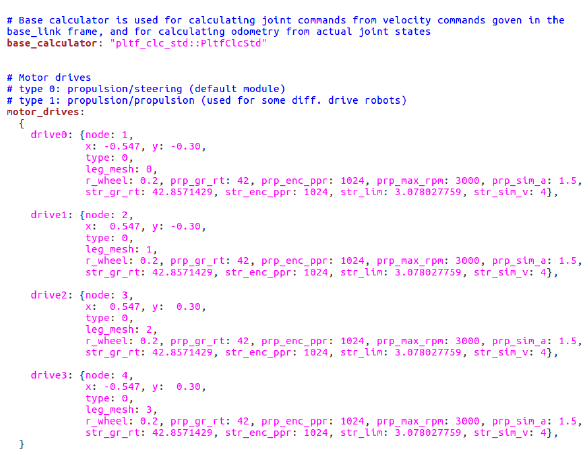
Figure 5: Excerpt of robot configuration file. Modules used to create a robot are listed here with key parameters.